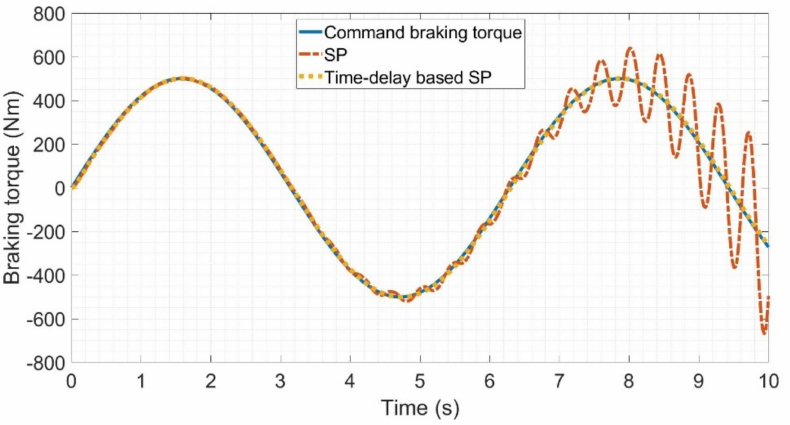
Figure 11. The simulation results with different time delays.